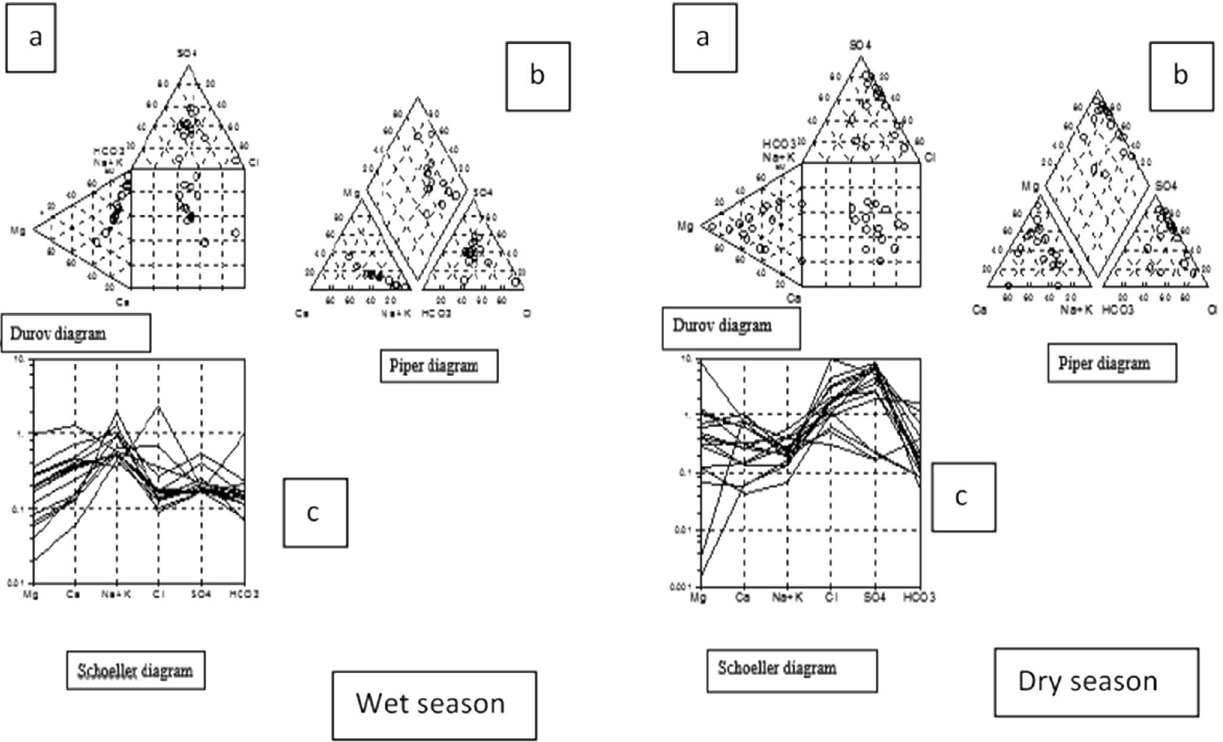
Fig. 2 Diagrammatical representation of hydrochemical species a Durov, b Piper and c Schoeller in Onitsha